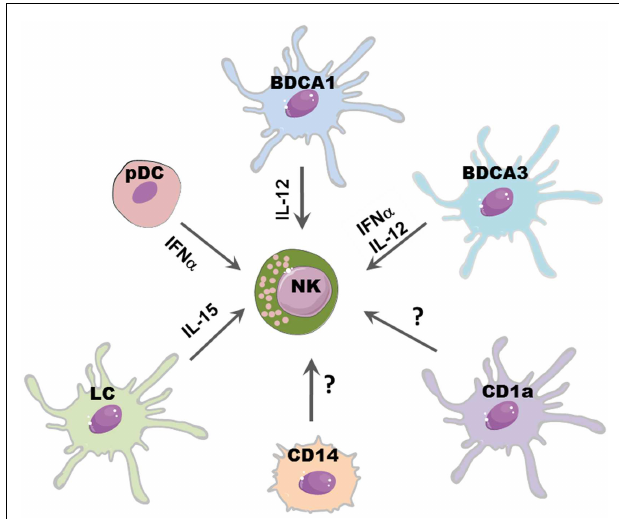
FIGURE 1 | DCs subsets may differently affect NK cell function . Distinct DC subsets reflect different capability to promote NK cell function: IL-15 released by LC may promote NK cell proliferation; IL-12, mainly produced by CLEC9A + /BDCA3 + DCs and BDCA1 + DCs, induces IFN- γ release and subsequentTh1 polarization ofT cells; NK cytolytic activity may be boosted by IFN- α secreted by pDCs and CLEC9A + /BDCA3 +